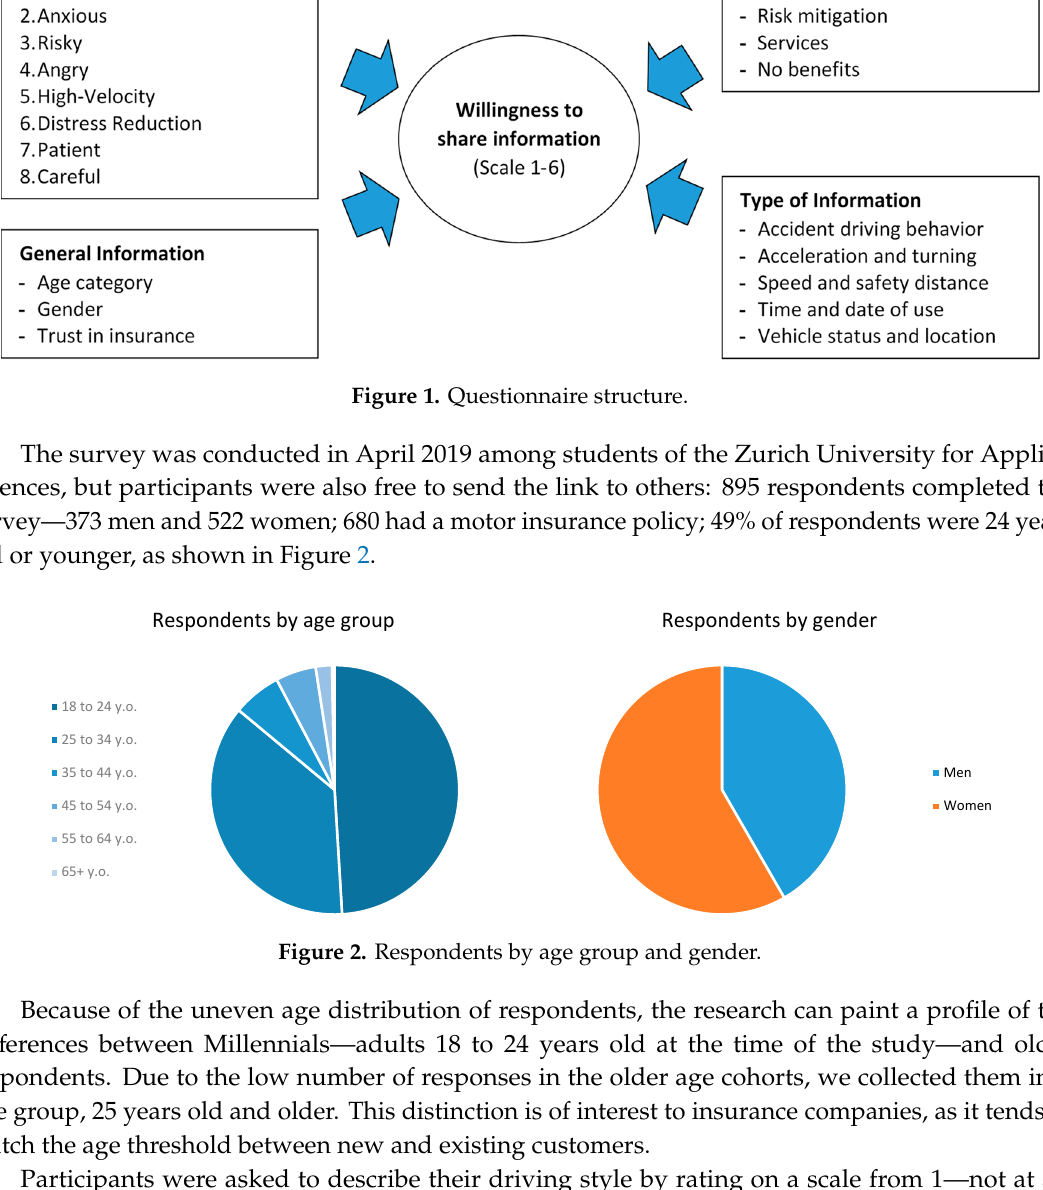
Table 1. Strength of preference for sharing information with insurance company.